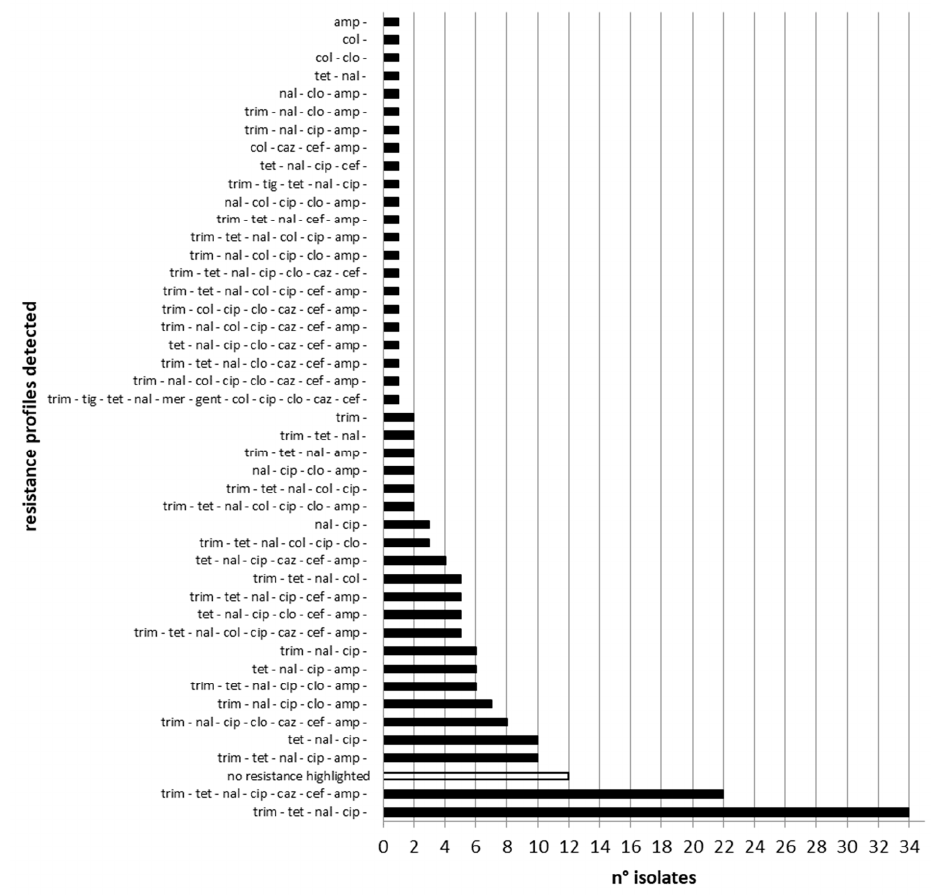
Table 2. Number and percentage of completely susceptible S. Infantis strains (S), isolates displaying intermediate resistance (I) or completely resistant (R) to Ampicillin (AMP), Cefotaxime (CEF), Ceftazidime (CAZ), Chloramphenicol (CLO), Cipro fl oxacin (CIP), Colistin (COL), Gentamicin (GEN), Meropenem (MERO), Nalidixic acid (NAL), Tetracycline (TET), Tigecycline (TGC), and Trimethoprim (TMP) and originating from poultry, mussels, and humans. Isolates from cow/calves, water bu ff alo, pig, and wild boars were summed and are denoted as“Other mammals.